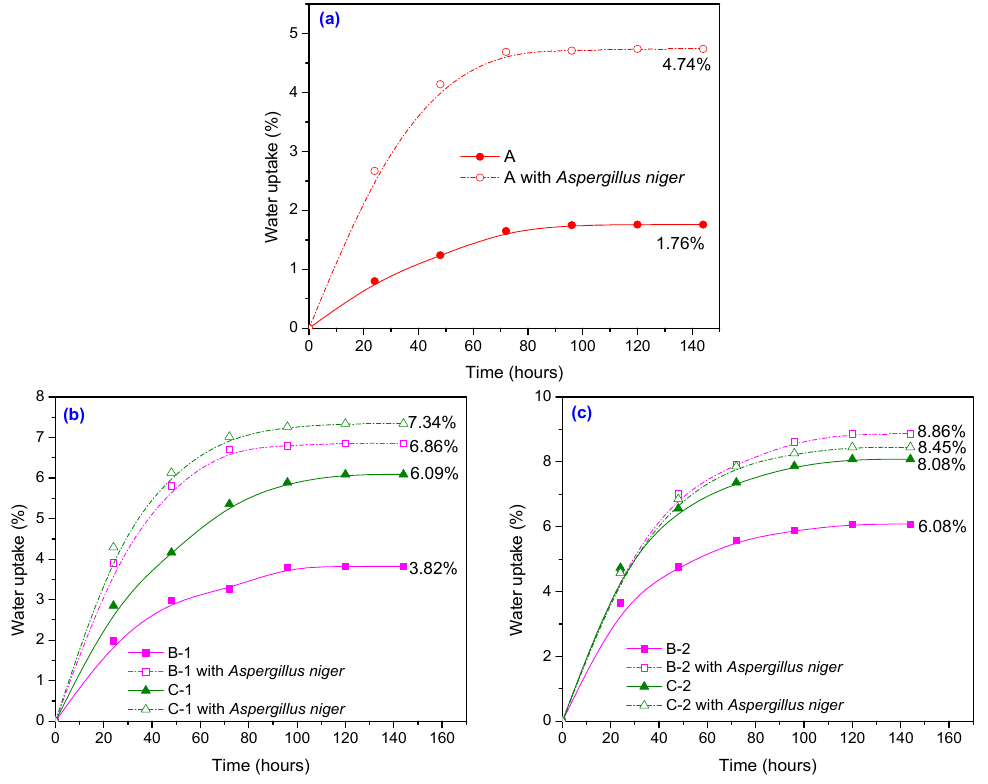
Figure 10. Water uptake depending on the amount of filler in composites at 23 ± 2 °C: ( a ) 0 phr; ( b ) 10 phr; ( c ) 20 phr.